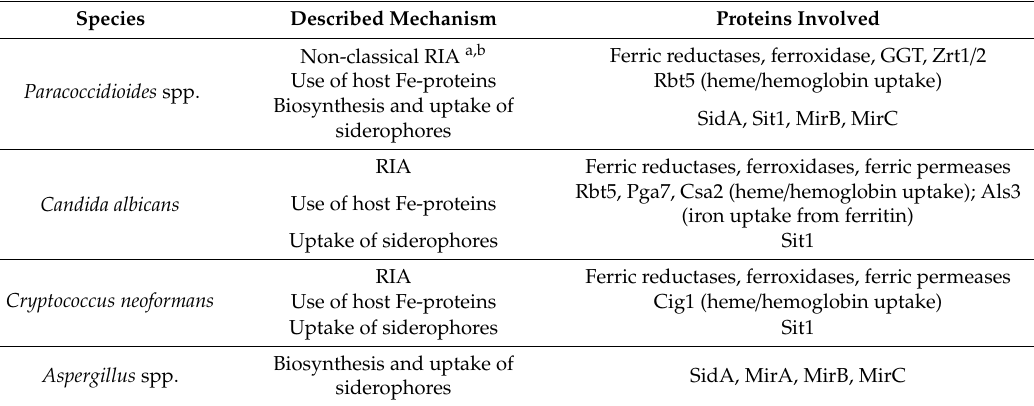
Figure 2. Overview of the mechanisms of iron uptake used in species of the Paracoccidioides complex. During iron deprivation Paracoccidioides spp. employ several mechanisms of iron uptake, such as siderophore transporters (Sit1, MirB, and MirC); binding to the heme group, mediated by Rbt5; or by iron and zinc transporters and iron-reductases. Rbt5 and SidA are described as virulence factors in Paracoccidiodes spp. “*” In P. lutzii , RIA is apparently ineffective, because after the metal reduction step, there is no uptake of this. “?” points to aspects that still require elucidation. Table 2. Mechanisms of fungi response to iron deprivation.